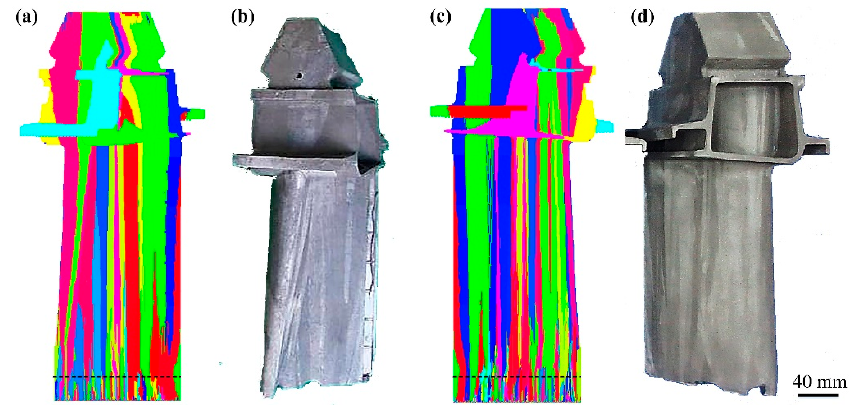
Figure 8. The simulated ( a , c ) and experimental results ( b , d ) of grain structures in LMC directional solidified industrial gas turbine blade. The grains below the black lines in the simulation results will be cut off in the following machining process.